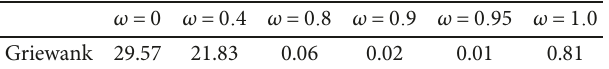
Figure 12: The in fl uence of inertia weight on algorithm Table 2: The average optimal fi tness value of the function under di ff erent inertia weights.